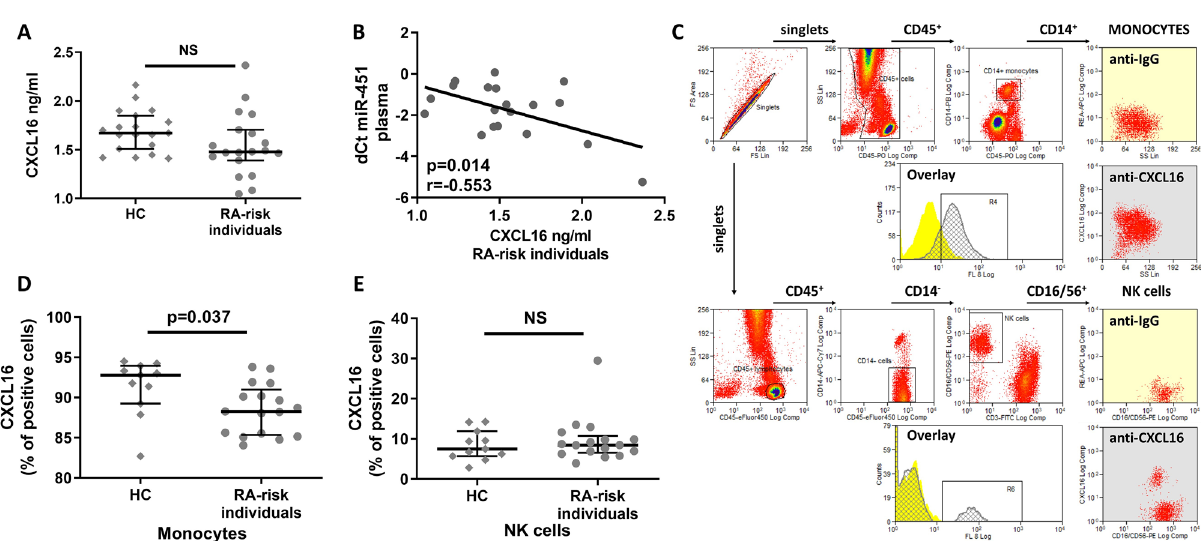
Figure 4. Analysis of CXCL16 levels in PBMC and plasma. ( A ) Plasma levels of CXCL16 were not different between HC and RA-risk individuals. ( B ) The negative correlation between plasma levels of CXCL16 and circulating miR-451 levels in RA-risk individuals with arthralgia. ( C ) Flow cytometry gating strategy and identification of the transmembrane form of CXCL16 in monocytes and NK cells. ( D ) Lower count of CXCL16- positive monocytes in RA-risk individuals with arthralgia compared to HC. ( E ) No differences in the numbers of CXCL16-positive NK cells were observed between RA-risk individuals with arthralgia and HC. NS, not significant . The gating strategy was created in Summit V4.3.01 software (DAKO Cytomation, Fort Collins, CO,